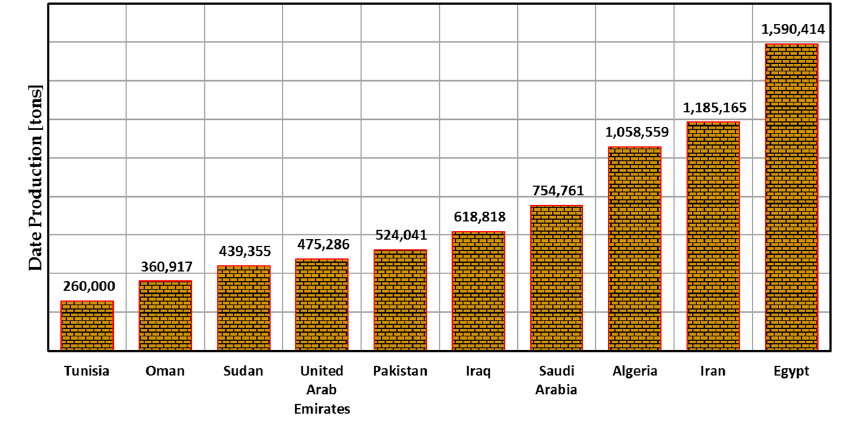
Figure 1. Top 10 global date-producing countries [15]. Energies 2019 , 12 , x 3 of 21